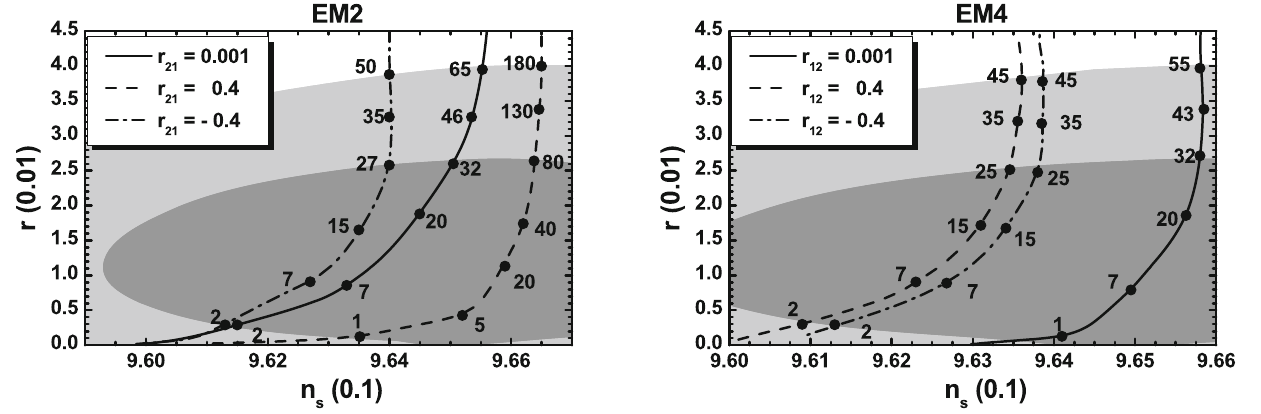
r 12 = 0 . 4 (dashed line), r 12 = − 0 . 4 (dot-dashed line). The points indicated on the curves correspond to various N values. The shaded corridors are identified as in Fig. 3